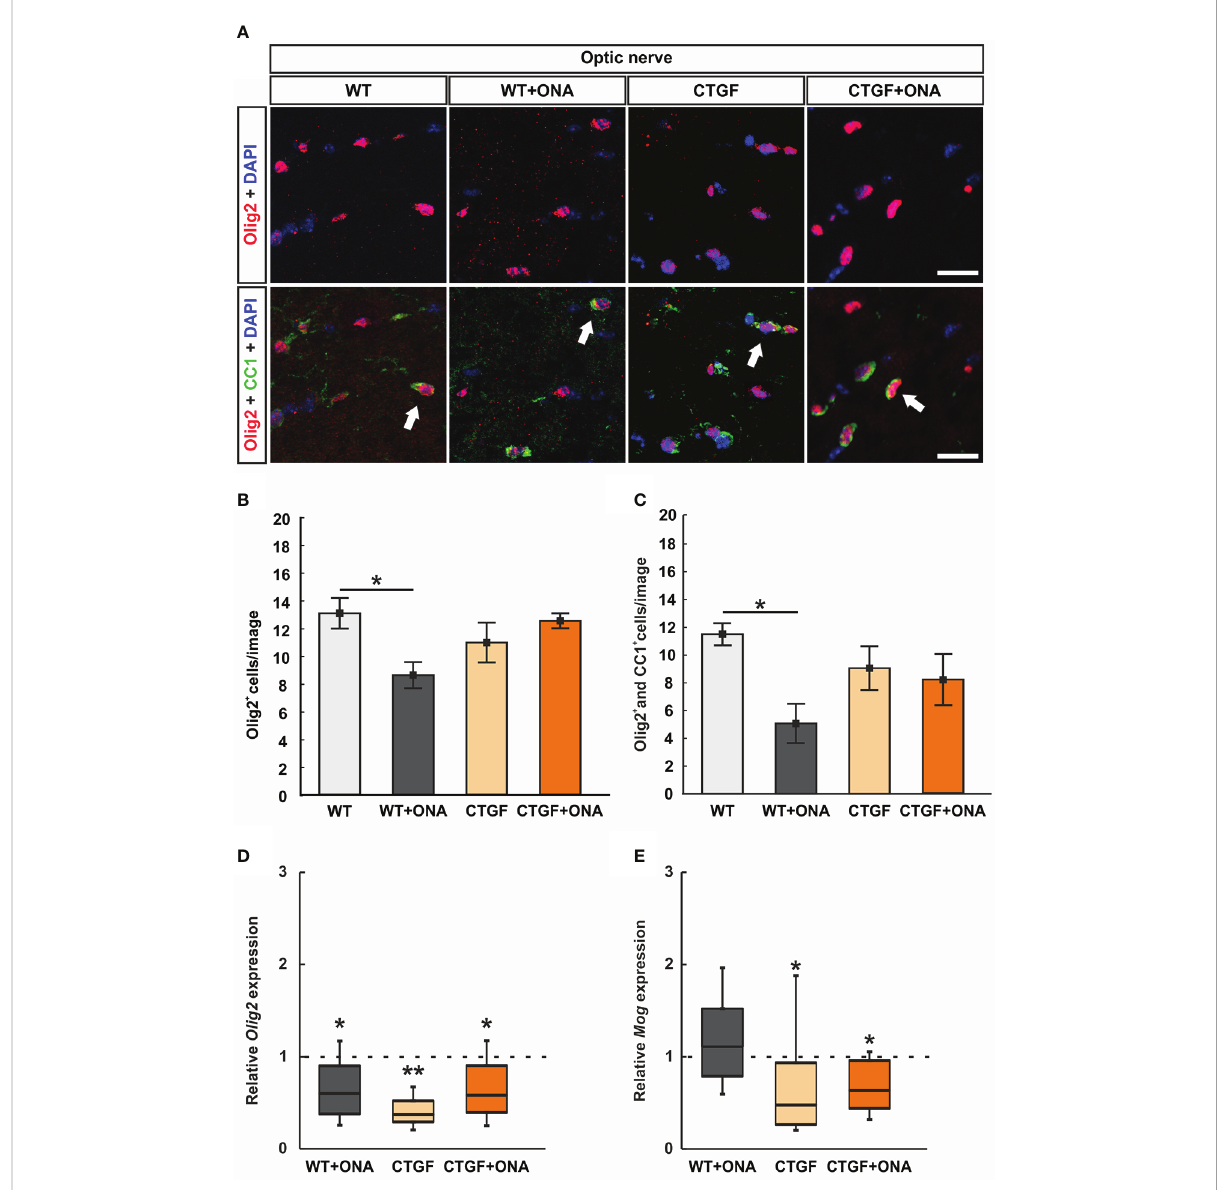
FIGURE 3 Loss of oligodendrocytes in WT+ONA mice. (A) Optic nerve sections were labelled with antibodies against anti-Olig2 (red) and anti-CC1 (green). Single Olig2 + cells were identi fi ed as immature oligodendrocytes, while a co-localization of Olig2 and CC1 double positive cells identi fi ed mature oligodendrocytes (arrows). (B) The number of single Olig2 + cells was signi fi cantly decreased in WT+ONA optic nerves compared to WT mice, while no alterations were noted in the CTGF and CTGF+ONA groups. (C) The number of Olig2 + and CC1 + double positive cells was signi fi cantly diminished in the WT+ONA animals compared to controls. No changes were observed within the other groups. (D) The mRNA expression levels of Olig2 were signi fi cantly decreased in WT+ONA, CTGF, and CTGF+ONA optic nerves compared to WT. (E) No alterations were noted in the mRNA expression levels of Mog in the WT+ONA group. In contrast, a signi fi cant downregulation could be observed in CTGF and CTGF+ONA optic nerves compared to WT. Values are mean ± SEM for immunohistology and median ± quartile ± minimum/maximum for RT-qPCR. The dotted lines in (D, E) represent the relative expression of the WT group. *p<0.05 and **p<0.01 vs . WT. Scale bars: 20